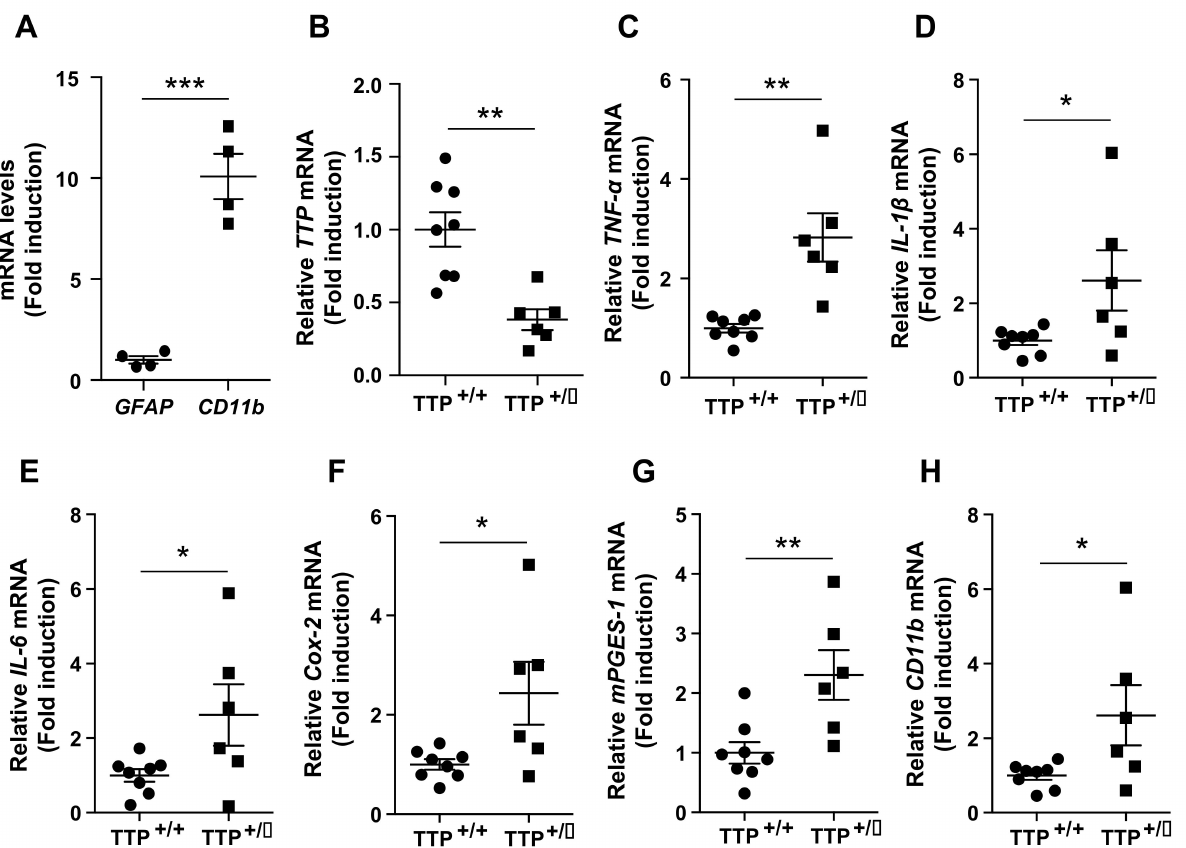
Figure 3. Deficiency of TTP leads to increased expression levels of genes involved in inflammatory responses. Primary microglia were extracted from the hypothalamus of both TTP-deficient and wild-type mice and seeded at 5 × 10 5 cells/well to determine mRNA expression. ( A ) Cultured hypothalamic primary microglial cells retain a 10-fold higher level of CD11b mRNA compared to that of Gfap . ( B ) qPCR data revealed a significant decrease in TTP mRNA in the primary microglial cells extracted from the hypothalamus of the TTP-deficient mice compared with that of wild-type mice. qPCR data display elevated mRNA expression of pro-inflammatory cytokines including ( C ) TNF- α , ( D ) IL-1 β , and ( E ) IL-6 , and genes involved in the synthesis of prostaglandin E 2 , including ( F ) Cox- 2 and ( G ) mPGES-1 , and ( H ) CD11b , a molecular marker for microglial activation, in the primary microglial cells extracted from the hypothalamus of the TTP-deficient mice compared with that in wild-type control mice. Data are presented as the mean ± SEM. n = 4 experiments per group for Figure 3A; n = 6–8 experiments per group for Figure 3B–H. All experiments were performed from at least three different preparations of microglial cells. * p < 0.05; ** p < 0.01; *** p < 0.001. SEM; standard error of the